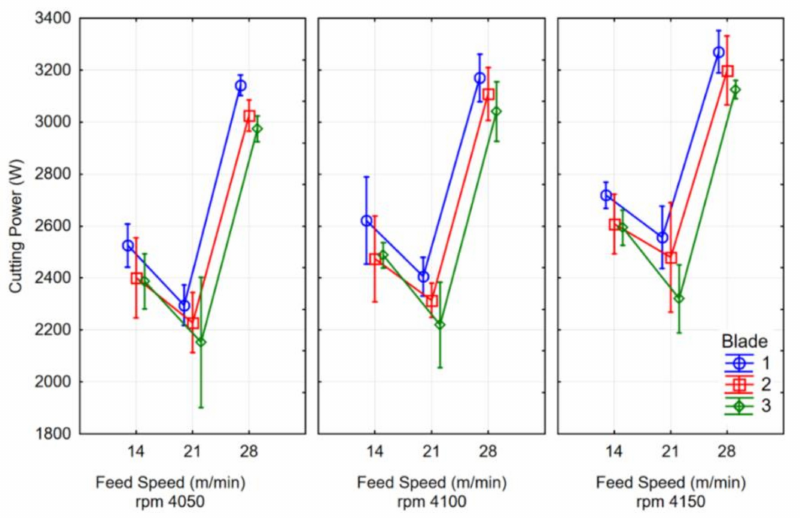
Figure 4. Effect of the feed speed and the design of the circular saw blades on cutting